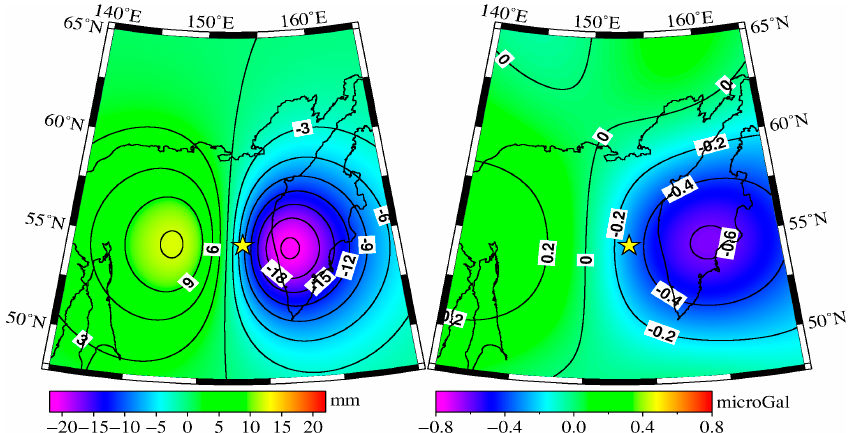
Figure 7. The coseismic vertical displacement ( left plot ) obtained from the dislocation theory [26], and the coseismic gravity changes ( right plot ) caused by the coseismic vertical deformation.